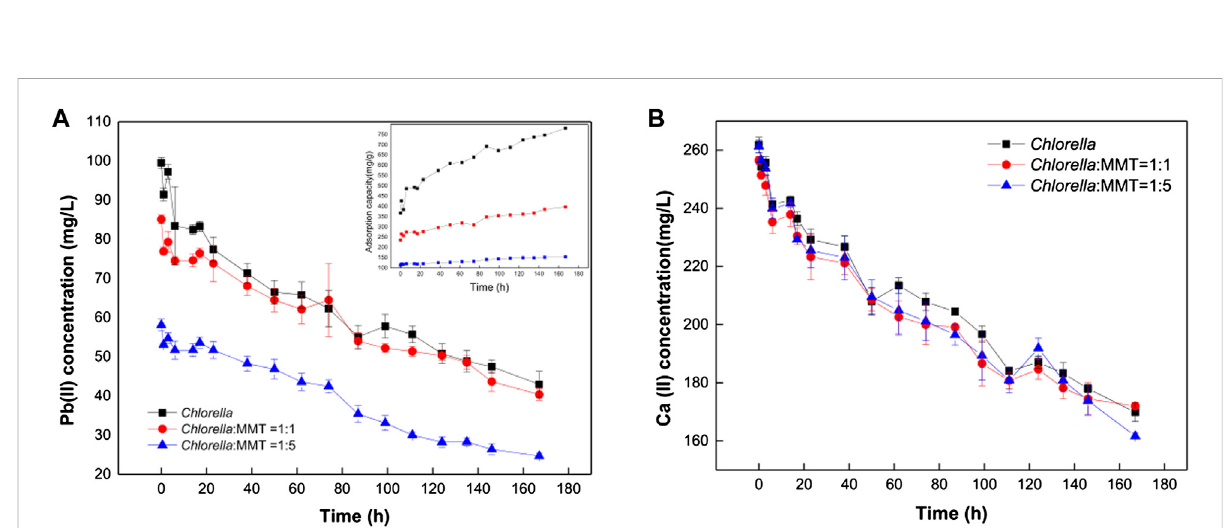
FIGURE 4 Variation of Pb(II) concentration (A) and Ca(II) concentration (B) in Chlorella and Chlorella – MMT (1:1 and 1:5) composite